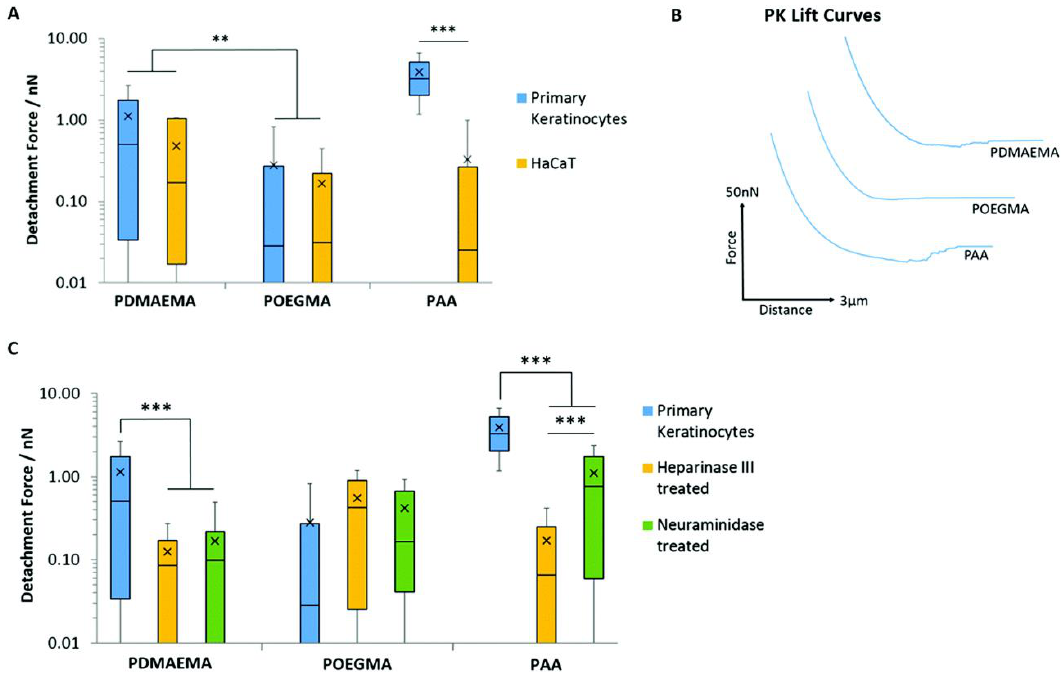
Figure 7. Detachment forces of polymeric brushes from cell monolayers ( A ), AFM lift curves ( B ) and detachment forces with and without treatment with enzymes ( C ) [13]. Published by The Royal Society of Chemistry.